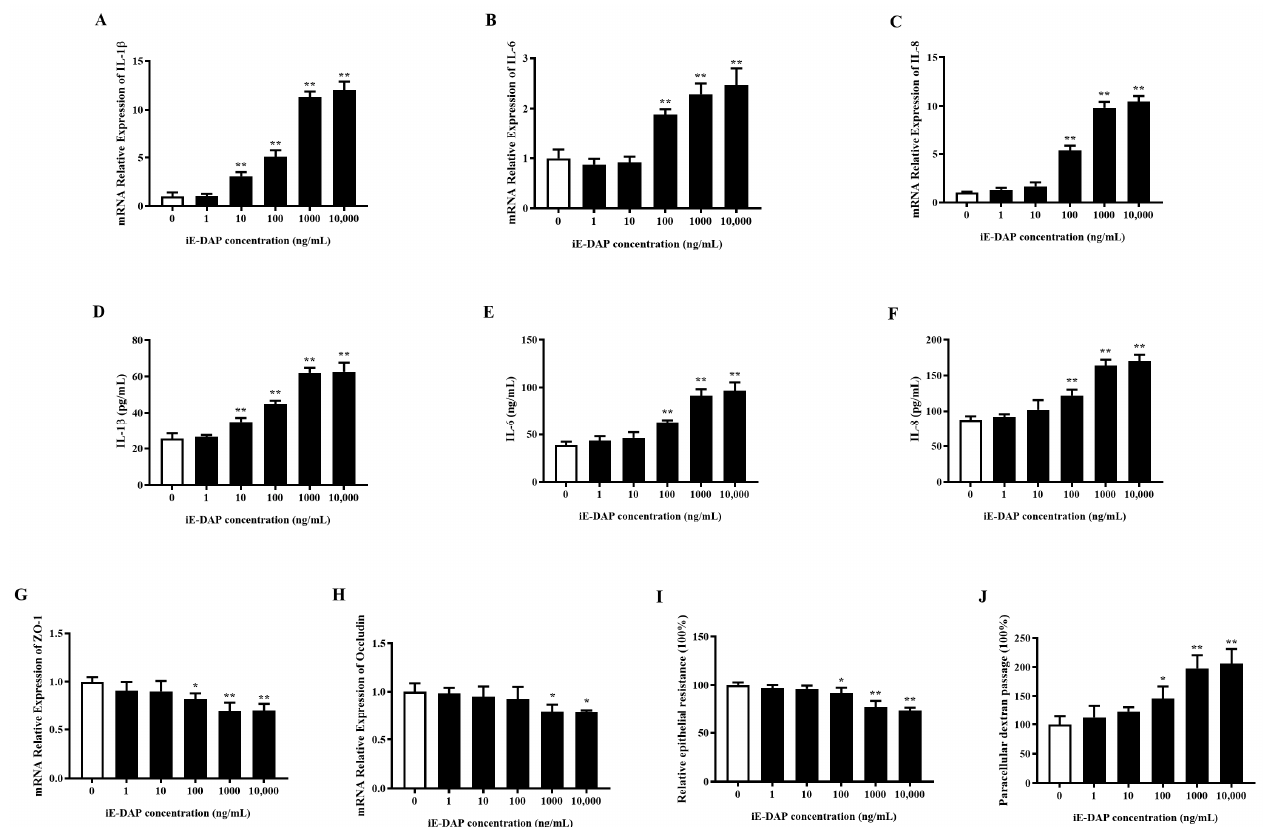
Figure 2. Effects of iE-DAP treatment on the inflammatory response and TJ integrity in BMECs. ( A – C ) Gene expression of inflammatory cytokines in BMECs after treatment with 0, 1, 10, 100, 1000 and 10,000 ng/mL iE-DAP for 12 h. ( D – F ) The concentration of inflammatory cytokines in culture supernatant of BMECs after treatment with iE-DAP. ( G , H ) Gene expression of TJ proteins in BMECs treated with different concentration iE-DAP for 12 h. ( I ) Relative epithelial resistance and ( J ) paracellular dextran passage of the BMEC monolayer after iE-DAP treatment. Results are shown as the mean ± SEM. * p < 0.05, ** p < 0.01, representing significant differences compared with